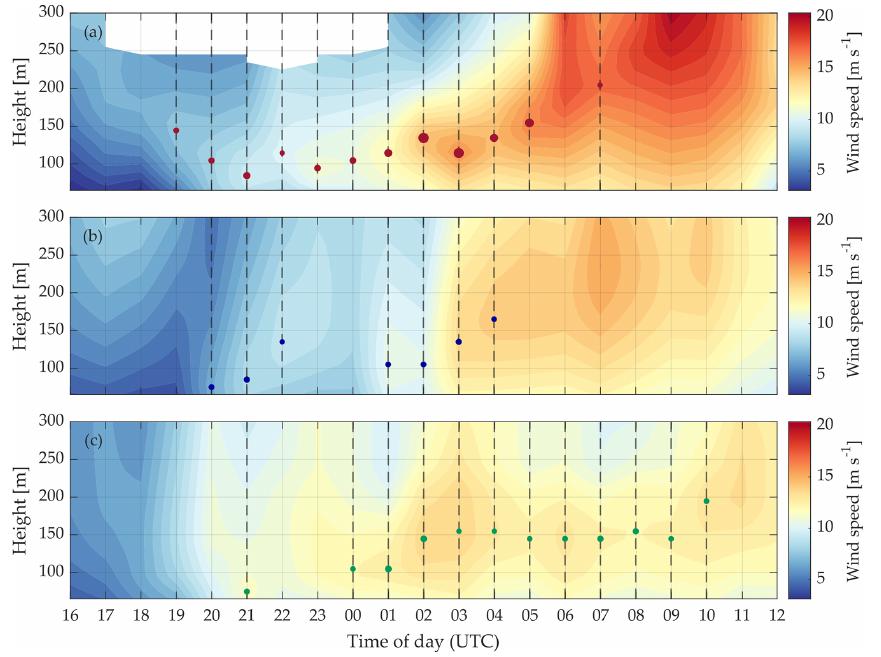
Figure 15. Time–height cross section of the wind speed (color filling) of the lidar (a) , ERA5 (b) and NEWA (c) during 4 March 2017 at 16:00UTC to 5 March 2017 at 12:00UTC. For each dataset, hours with a detected LLJ are marked with a vertical dashed line, and the core height of the jet is indicated with a dot. The size of the dot indicates the falloff of the LLJ (bigger points indicate stronger falloffs). Missing data are shown in